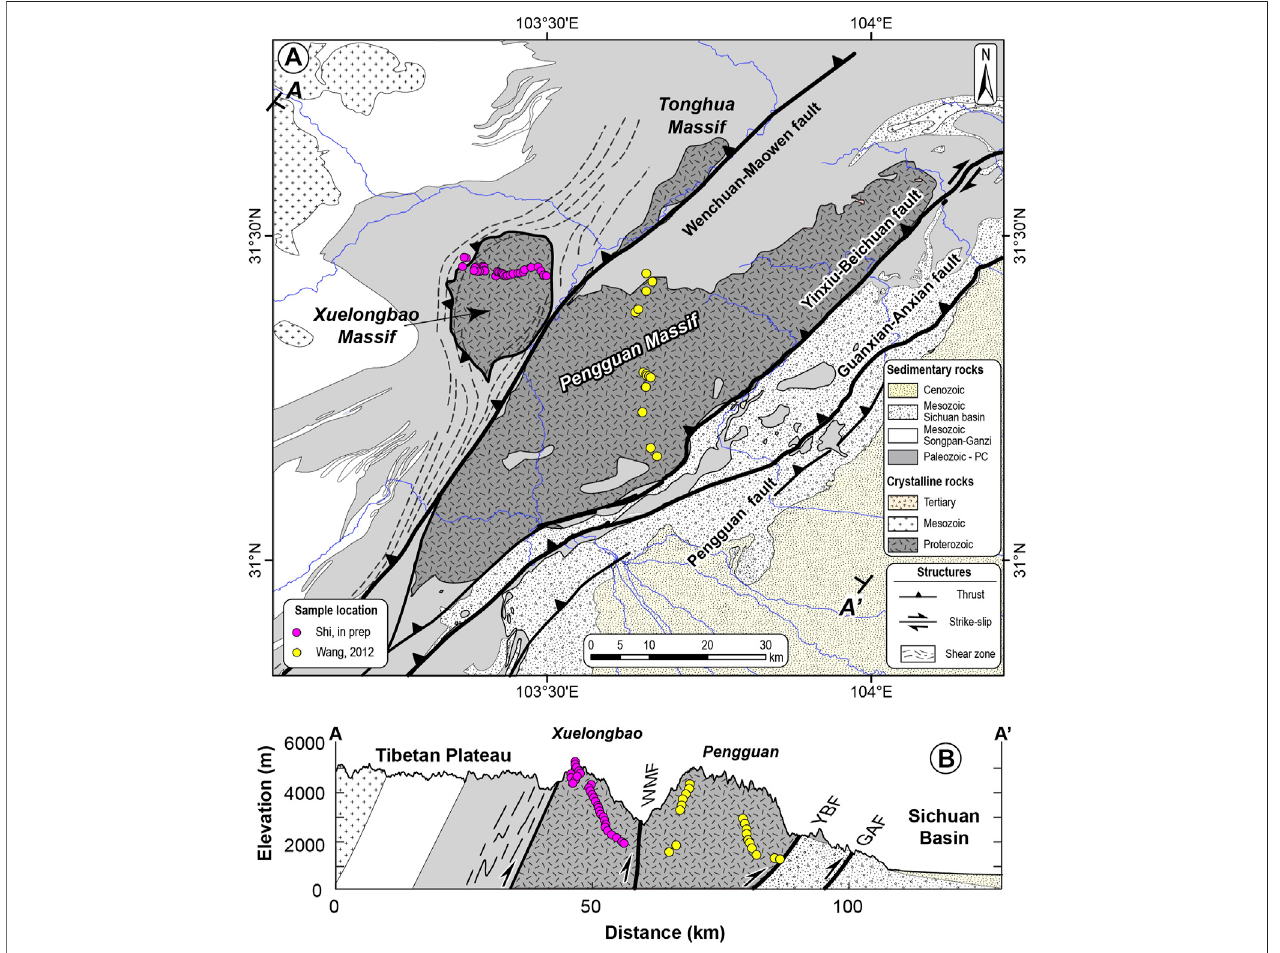
FIGURE 2 | (A) Simpli fi ed geology of the Longmen Shan and western Sichuan Basin after Burch fi el et al., 1995; Kirby et al., 2002; Airaghi et al., 2018a. Sample locationsofdatausedinthispaperareshownincoloredcircles.Yellow — datafromWangetal.,2012inthePengguanMassif.Pink — datafromShietal.(inpreparation) 1 from the Xuelongbao Massif. (B) Cross-section showing the location of sample transects relative to major structures in the Longmen